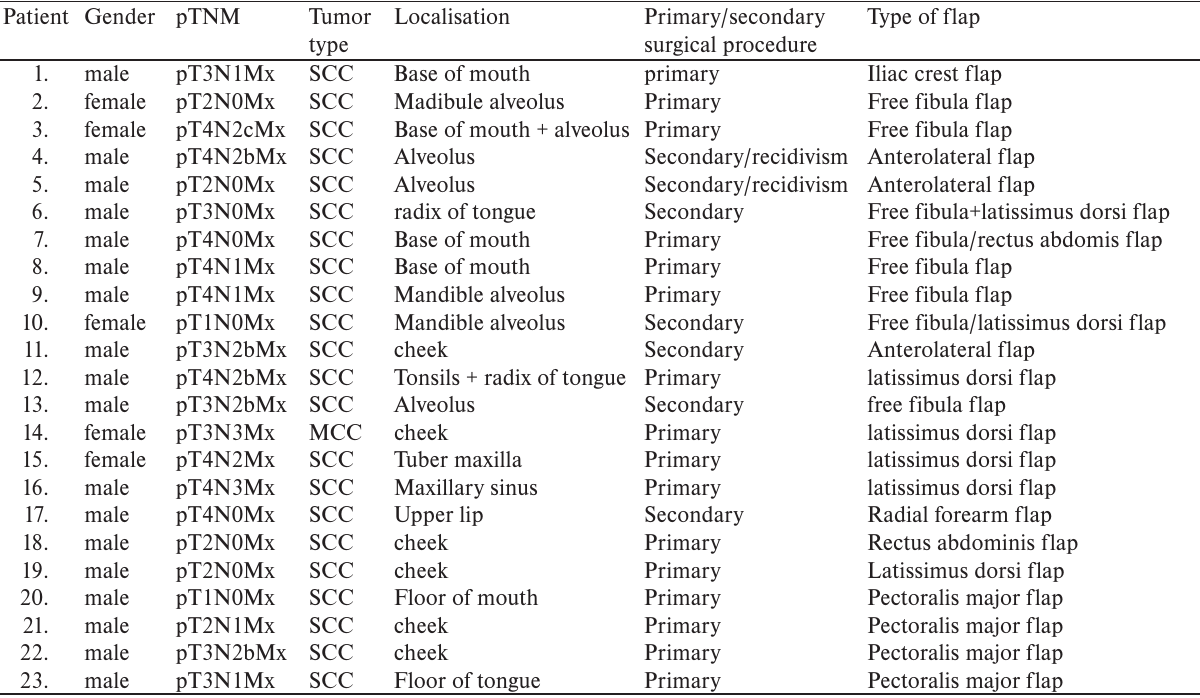
Table 1. Summary of patients after reconstruction with free and distant